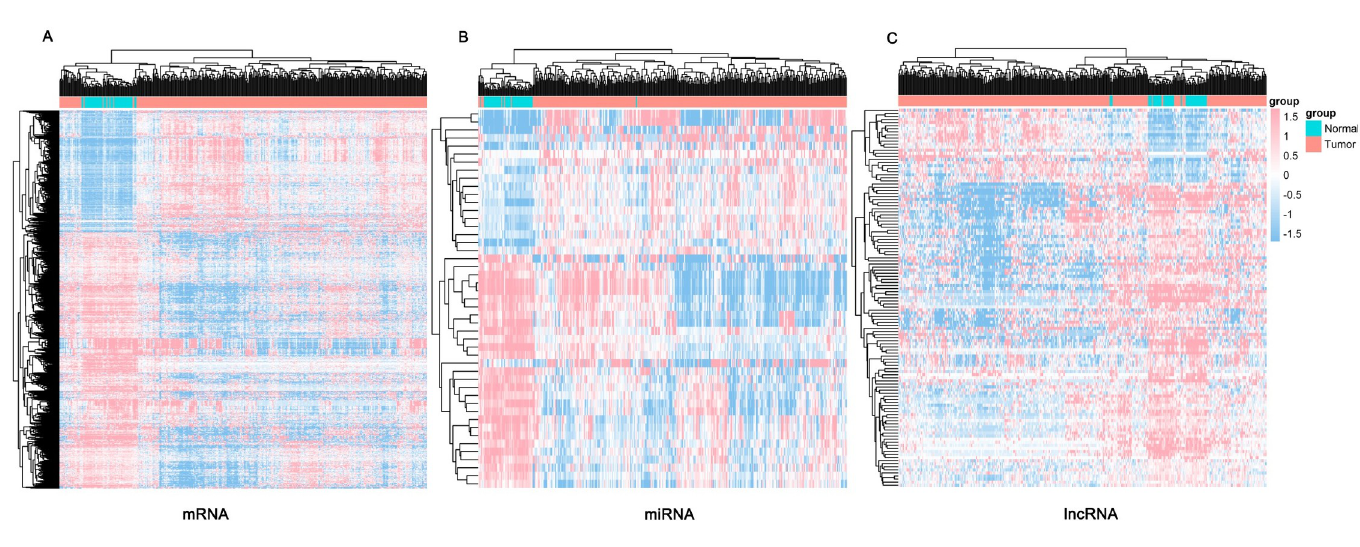
Fig 2. Differential expression profile of RNAs in LIHC. (A) Heat map of differentially expressed mRNAs. (B) Heat map of differentially expressed lncRNAs. (C) Heat map of differentially expressed miRNAs. The red represented the higher expression levels and the green represented lower expression levels. The rows and the columns represented the DERNAs and samples